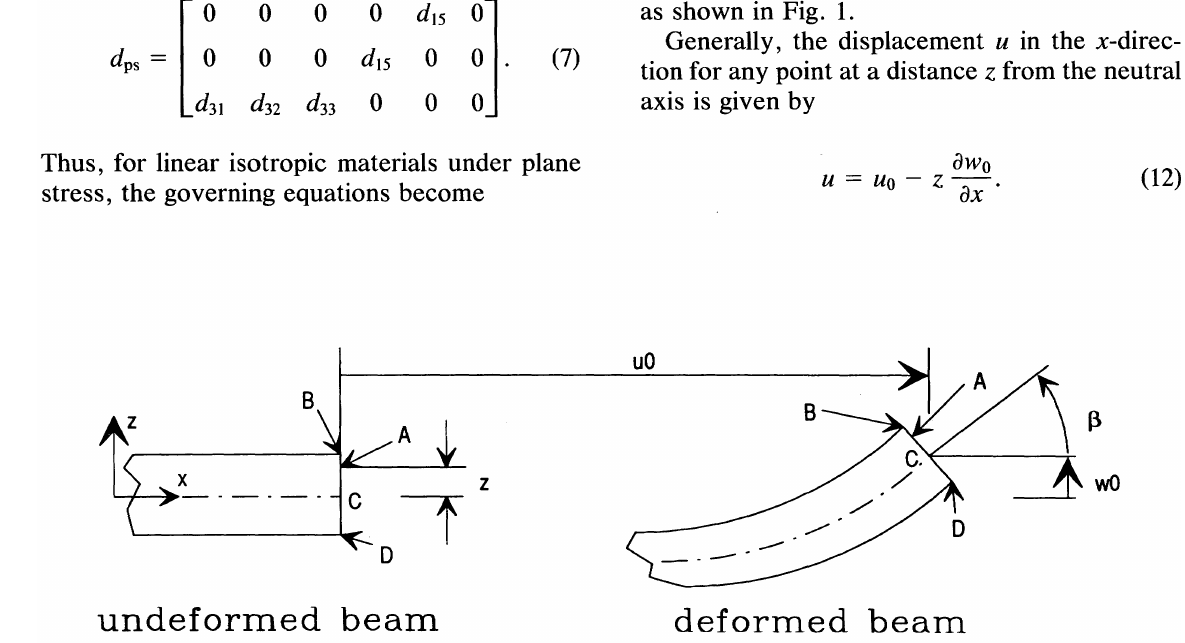
FIGURE 1 Displacement in undeformed coordinate